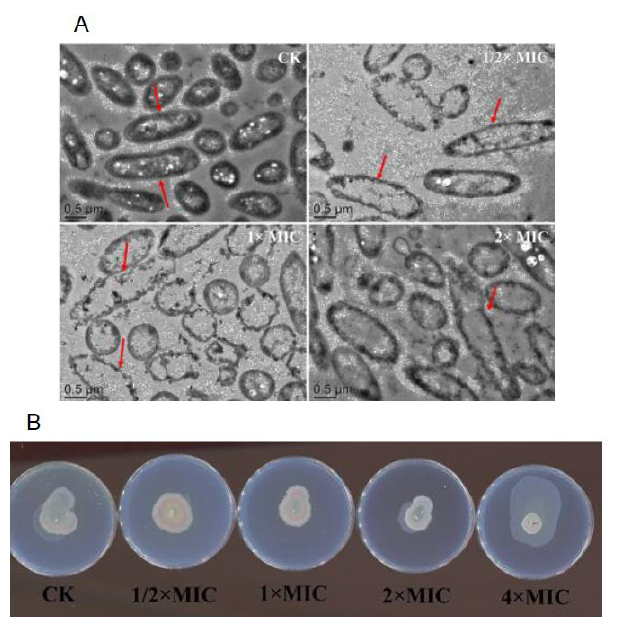
Figure 5. Effect of lemon verbena essential oil on Pseudomonas D4 under transmission electron microscopy. ( A ) Transmission electron microscope images of Pseudomonas D4 treated with different concentrations of lemon verbena essential oil (0 × MIC, 1/2 × MIC, 1 × MIC, and 2 × MIC). ( B ) Anti- QS assay of Pseudomonas D4 treated with different concentrations of lemon verbena essential oil (0 × MIC, 1/2 × MIC, 1 × MIC, and 2 × MIC).